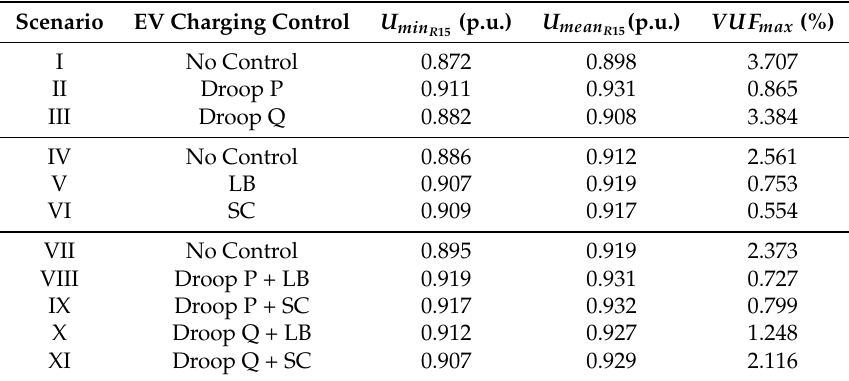
Table 6. Summarized results for the scenarios